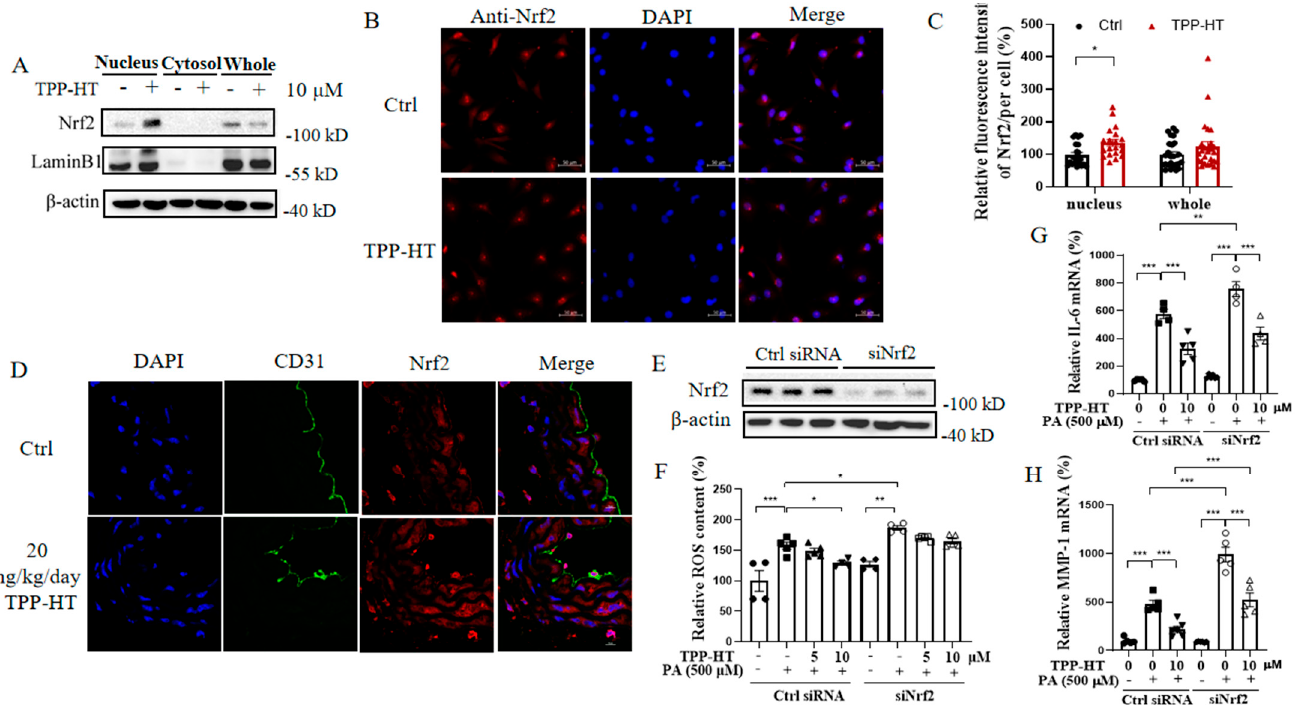
Figure 6. TPP-HT pretreatment abrogates PA-induced excessive ROS production by promoting Nrf2 nuclear localization. ( A ) Protein levels of nuclear, cytosolic and total Nrf2 in HAECs pretreated with TPP-HT (10 μ M) for 24 h. ( B ) Fluorescence intensity of FoxO1, scale bar = 50 μ m. ( C ) Arbitrary unit for the fluorescence intensity of FoxO1 (statistical cell number for control is 25, for TPP-HT is 25). ( D ) Nrf2 expression by immunofluorescence in the thoracic aorta, CD31 as the biomarker for endothelial cells in vessel, scale bar = 10 μ m. Nrf2 expression levels under siNrf2 conditions. ( F ) ROS content. ( G ) mRNA level of IL-6. (H) mRNA level of MMP-1. Values are mean ± SEM from at least three independent experiments. * p < 0.05, ** p < 0.01, *** p < 0.001.